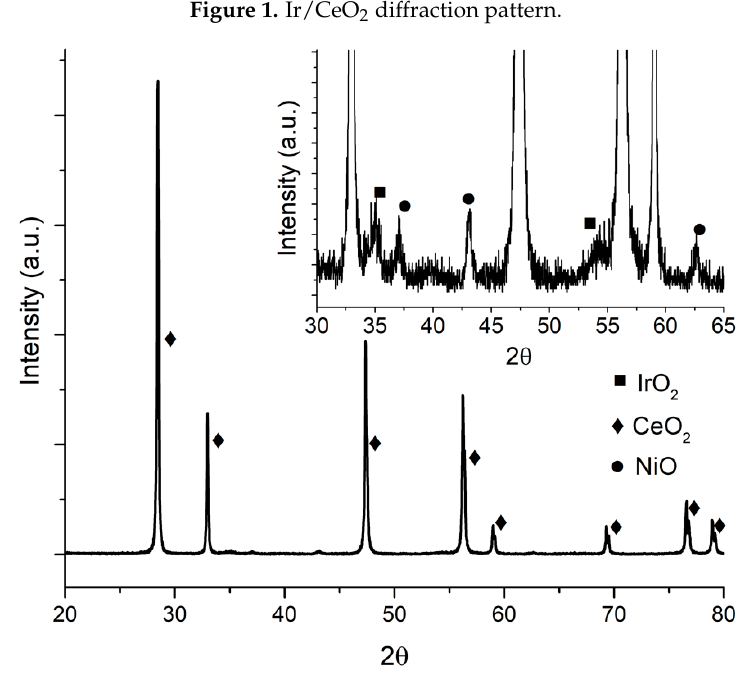
Figure 1. Ir/CeO 2 diffraction pattern.